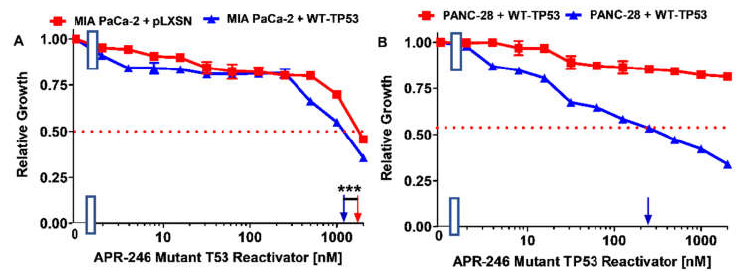
Figure 2. The ability of APR-246 to suppress the growth of PDAC cells is dependent on the presence of either an WT-TP53 or mut-TP53 protein. Panel ( A ) MIA-PaCa-2 + pLXSN cells (control cells lacking WT-TP53 but containing GOF TP53 and pLXSN) (red squares) and MIA-PaCa-2 + WT-TP53 cells (containing both WT-TP53 and GOF TP53) (blue triangles). Panel ( B ) PANC-28 + pLXSN cells (lacking detectable TP53 but containing and pLXSN) (red squares) and PANC-28 + WT-TP53 cells (containing both WT-TP53 and GOF TP53) (blue triangles). These experiments were repeated 4 times, and similar results were obtained. Blue and red arrows on the X-axis indicate when the IC 50 s were estimated, * = p < 0.05, NS, not statistically significant.